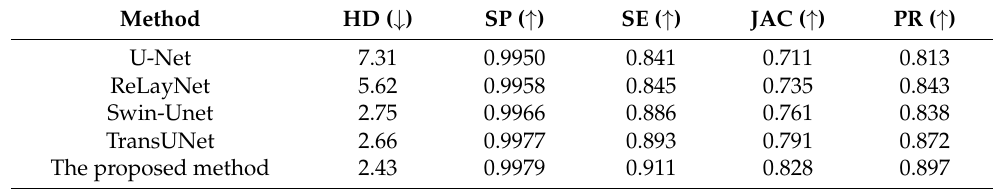
Table 2. Quantitative comparison of evaluation indicators of various methods.